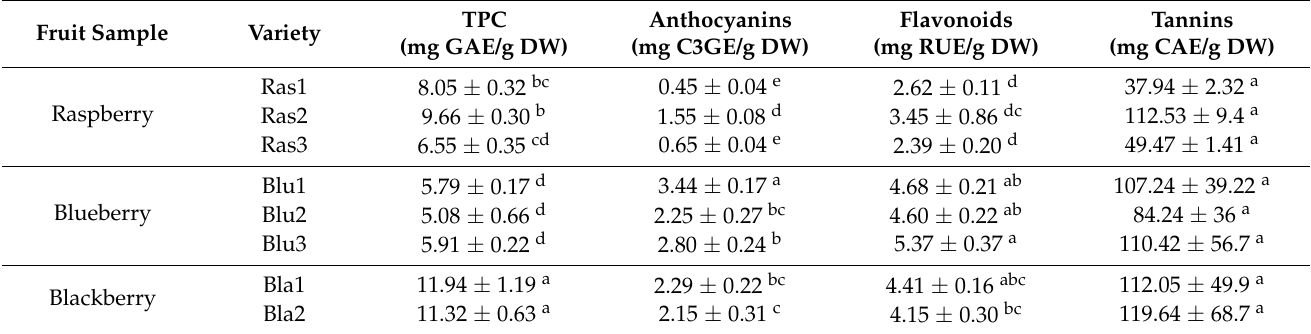
Table 1. Phenolic compound concentration in eight varieties of Mexican